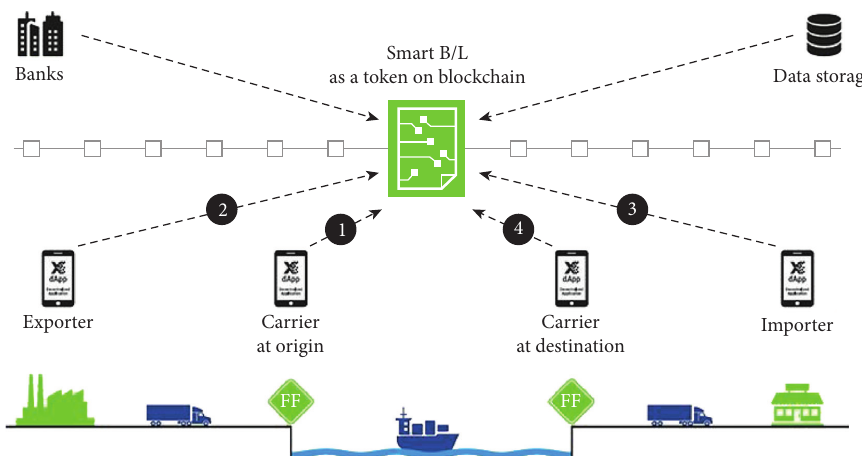
Figure 2: Blockchain-based B2B transaction path diagram for cross-border